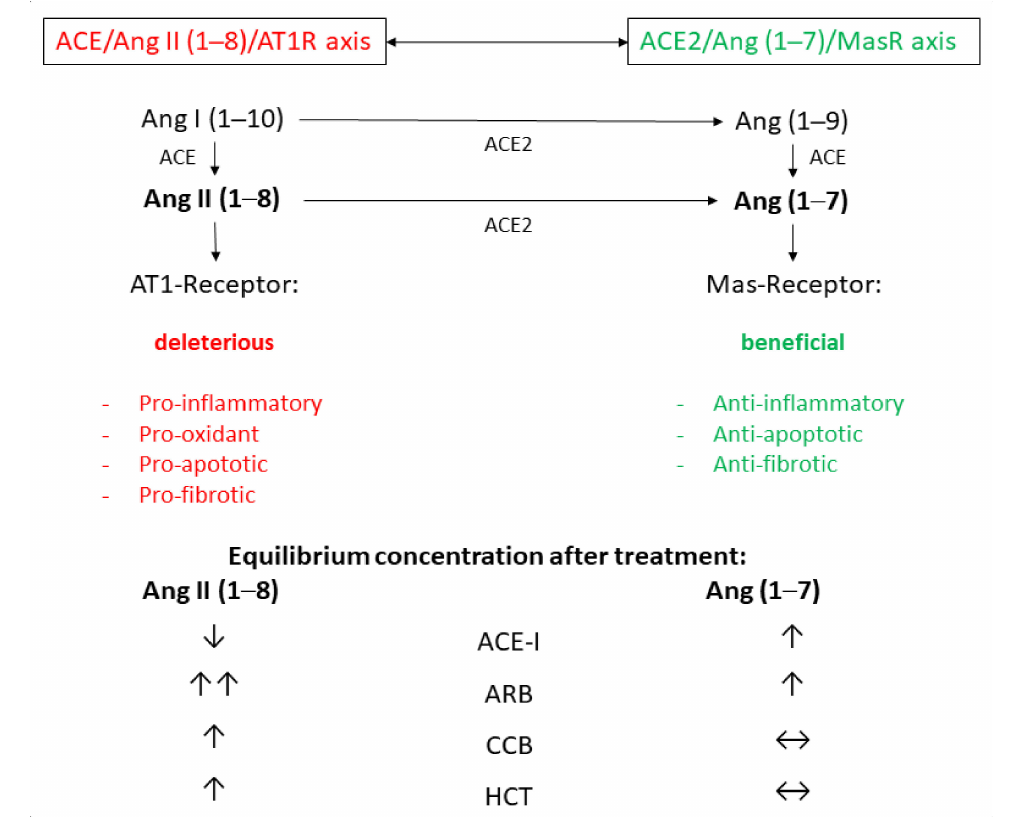
Figure 2. Effect of treatment initiation on Ang II and Ang (1–7) equilibrium concentrations in context of typical effects of each medication. ACE = angiotensin-converting-enzyme, ACE-I = Angiotensin-converting-enzyme inhibitor (perindopril), ARB = angiotensin-receptor blocker (olmesartan), CCB = calcium channel blocker (amlodipine), HCT =